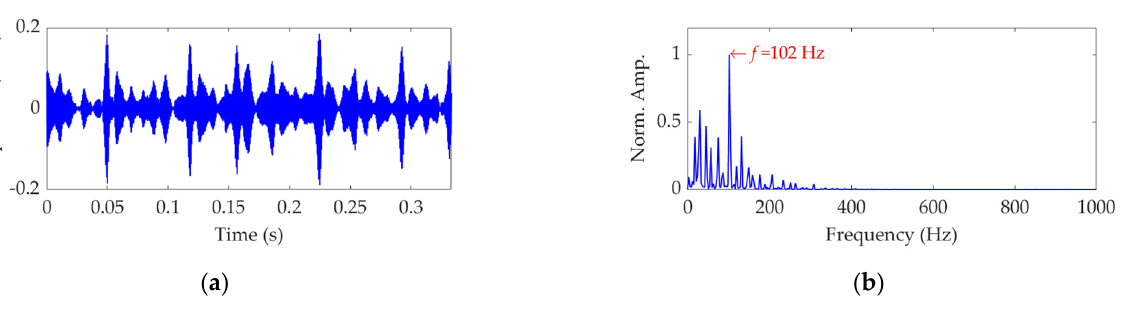
Figure 21. The target mode obtained by VMD: ( a ) time − domain waveform and ( b ) SES.